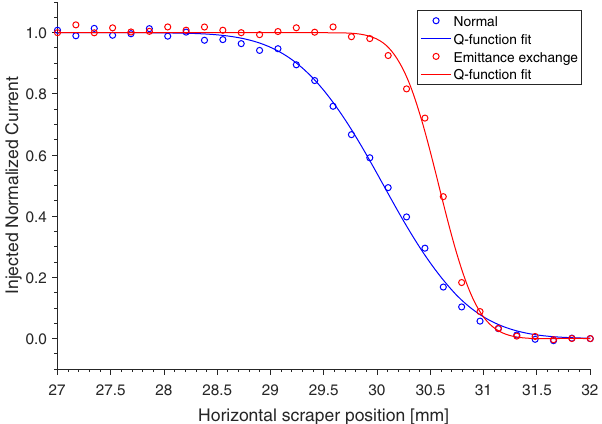
FIG. 15. Measurement of normalized injected current when the horizontal aperture is limited by a scraper in the storage ring. The scraper can be inserted significantly more when the emittance exchange technique is which leads to an estimate of the horizontal beam size, σ x , at the scraper position. The ratio between the beam sizes is found as